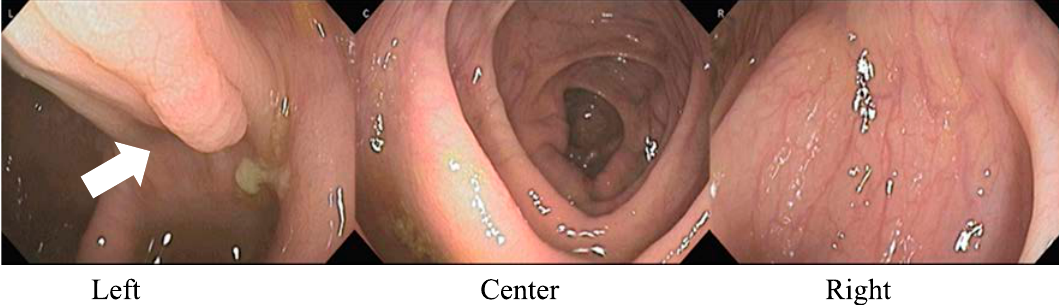
Figure 1 Full-spectrum endoscopy (FUSE) images. An arrow indicates a polyp that was observed only with the